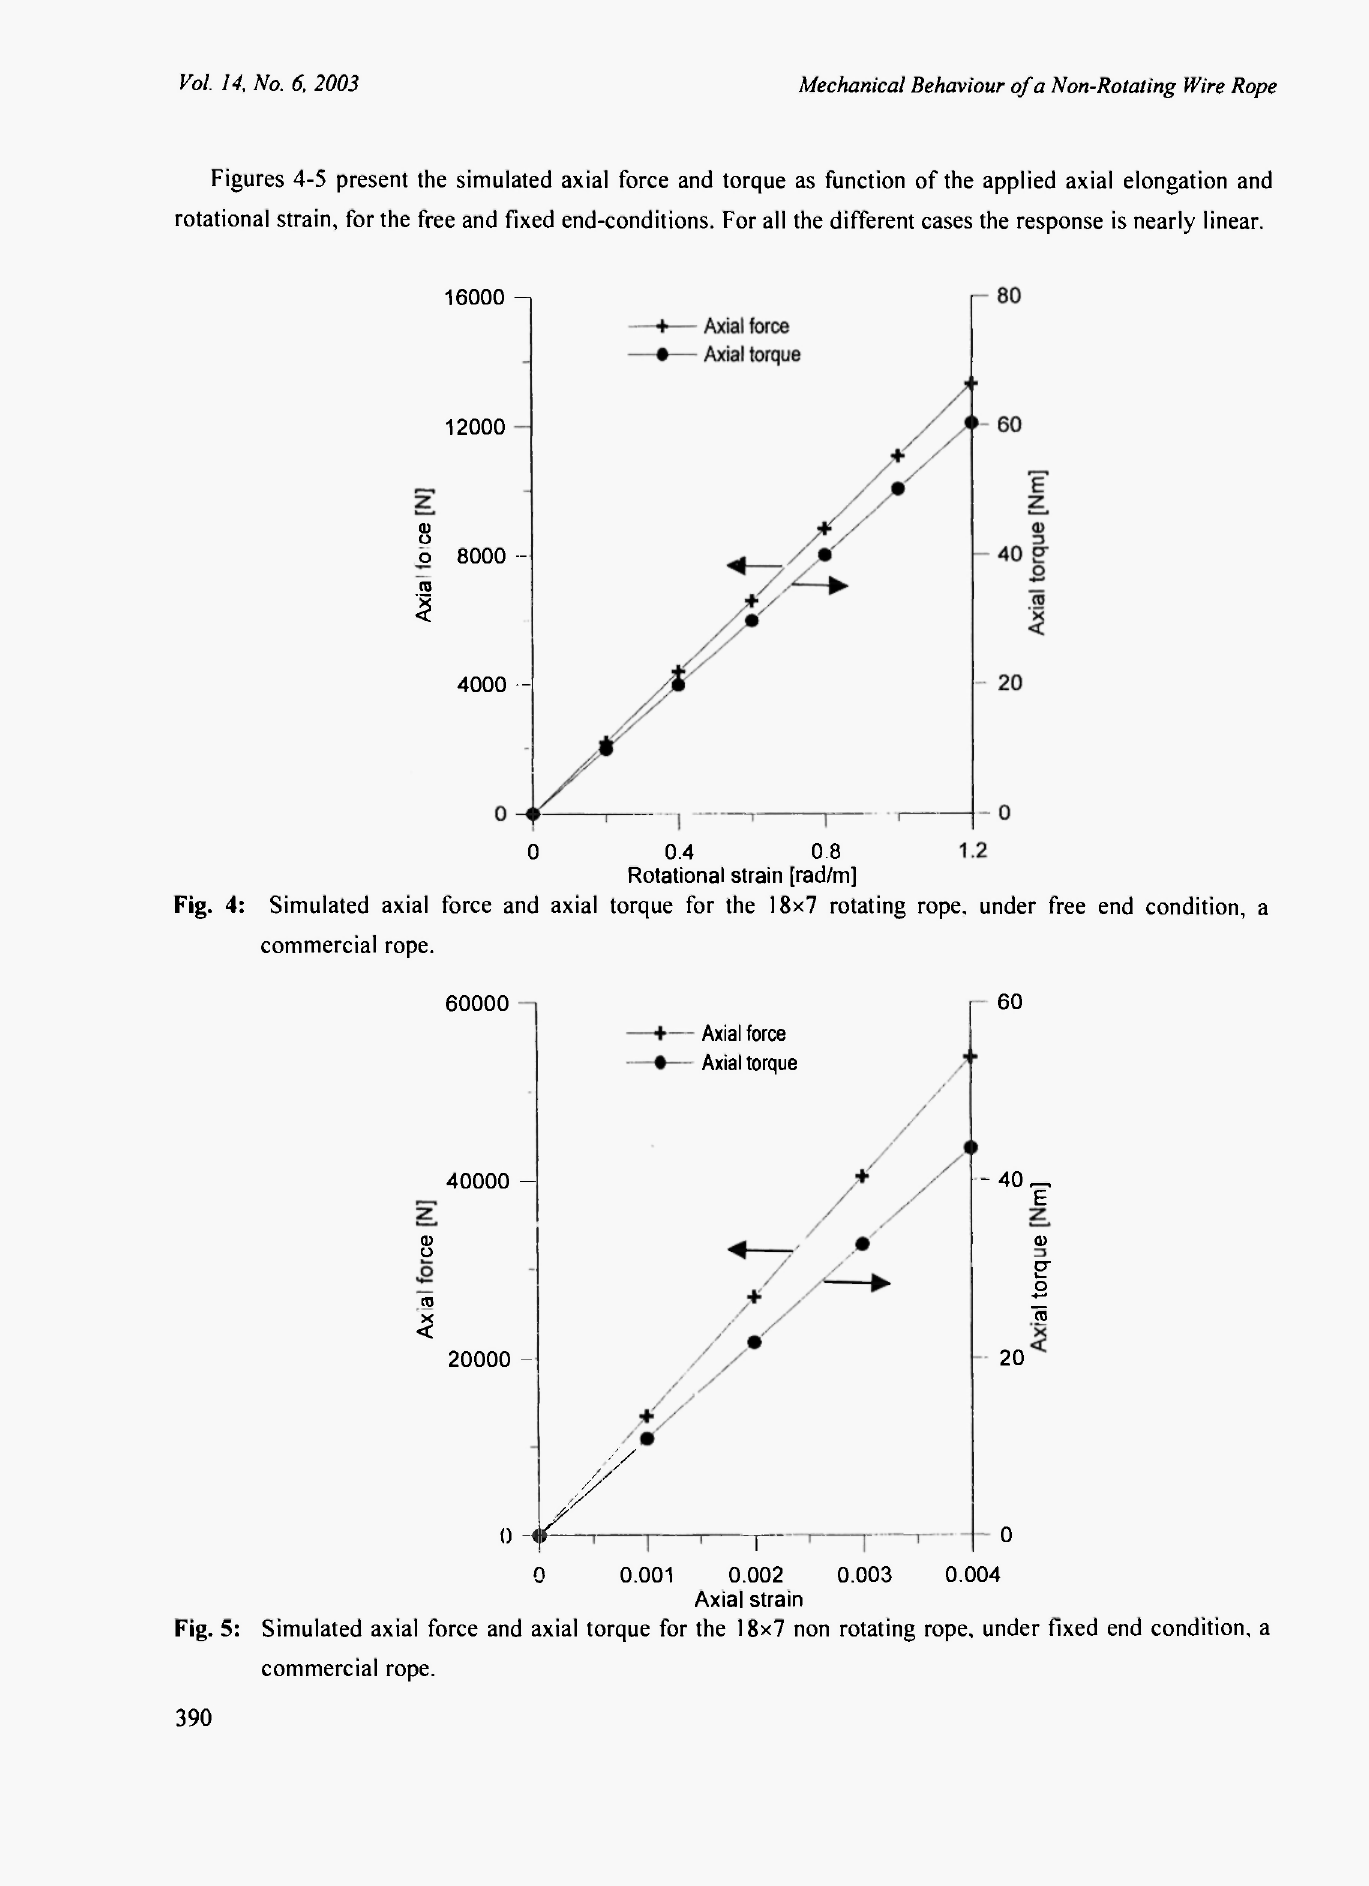
Fig. 4: Simulated axial force and axial torque for the 18x7 rotating rope, under free end condition, a commercial rope.